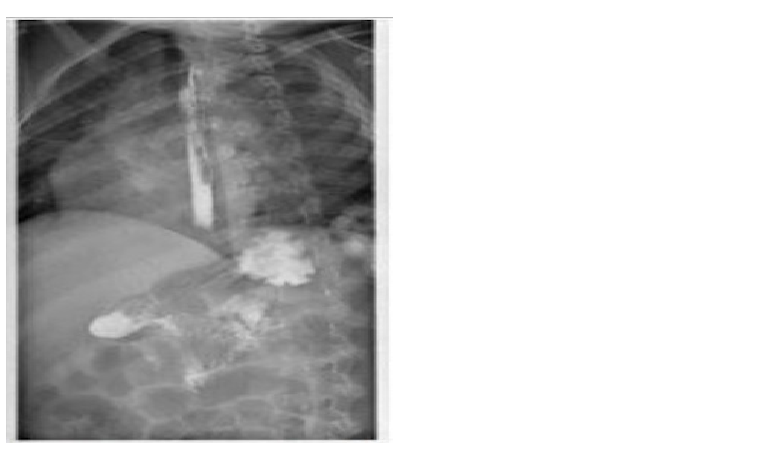
Figure 4. Esophagram demonstrating irregularity in the middle esophagus, with no extravasation of fluid.